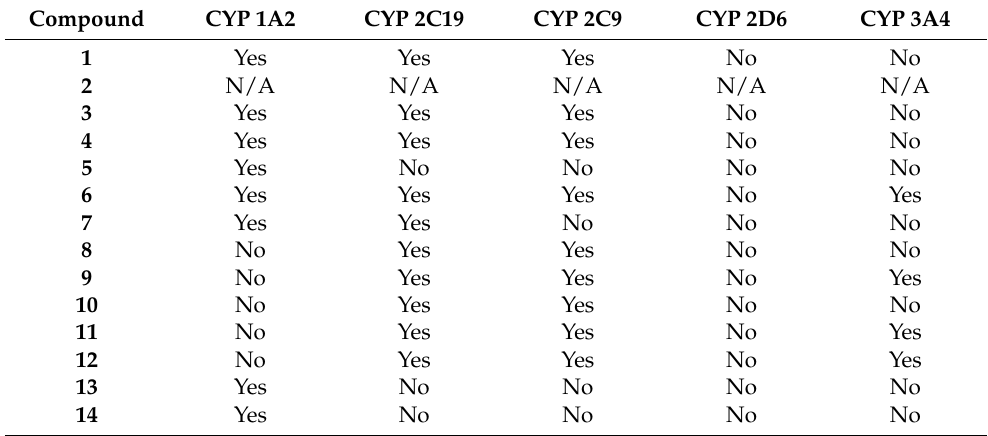
Table 6. The CYP enzyme-inhibition profile for the 14 N-heterocycle Derivatives using the SWIS- SADME webserver.